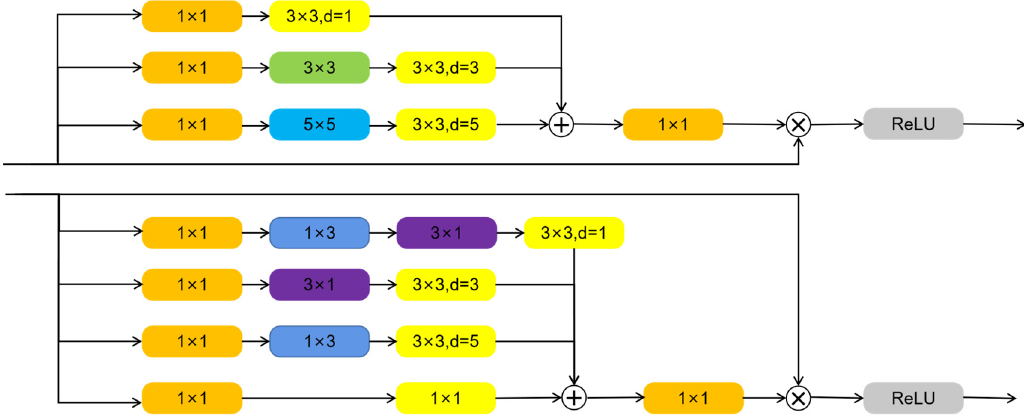
Figure 6. Receptive field enhancement module.